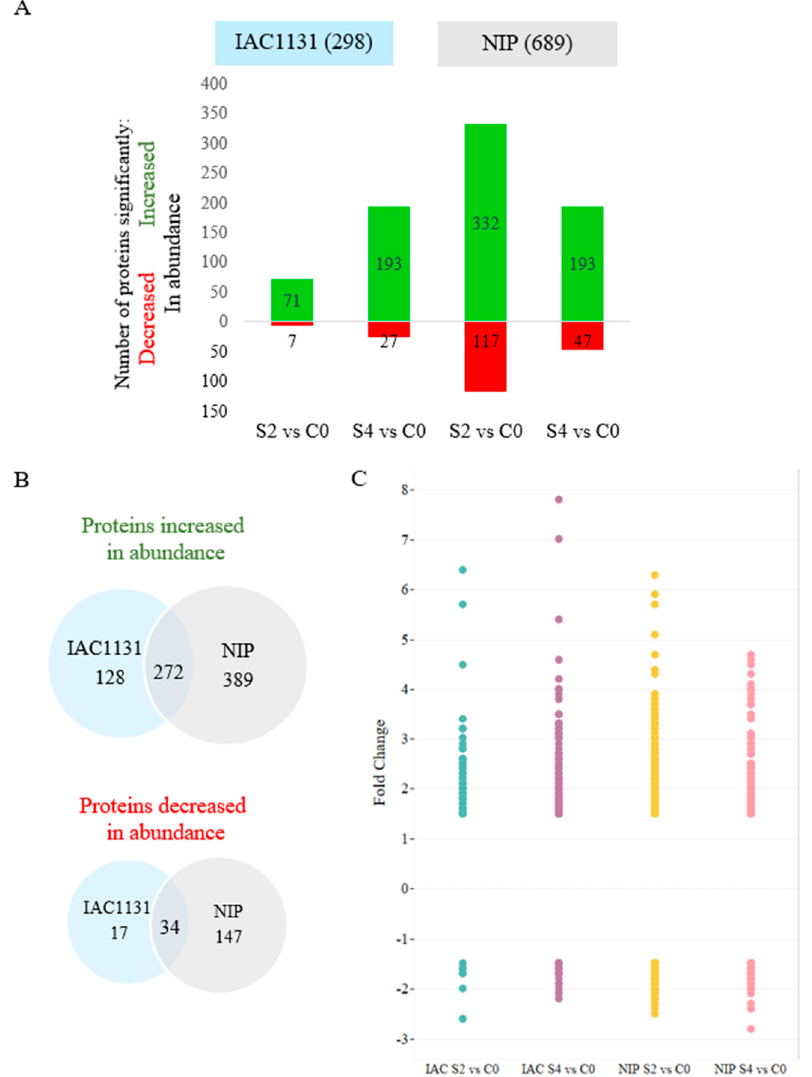
Figure 2. Differential protein expression of two rice genotypes after multiple abiotic stress treatment. ( A ) Number of significantly differentially expressed proteins seen at each time point for each genotype. ( B ) Unique and common proteins significantly increased and decreased in abundance across IAC1131 and Nipponbare. ( C ) Range of fold-change of DEPs in both genotypes after stress treatments.